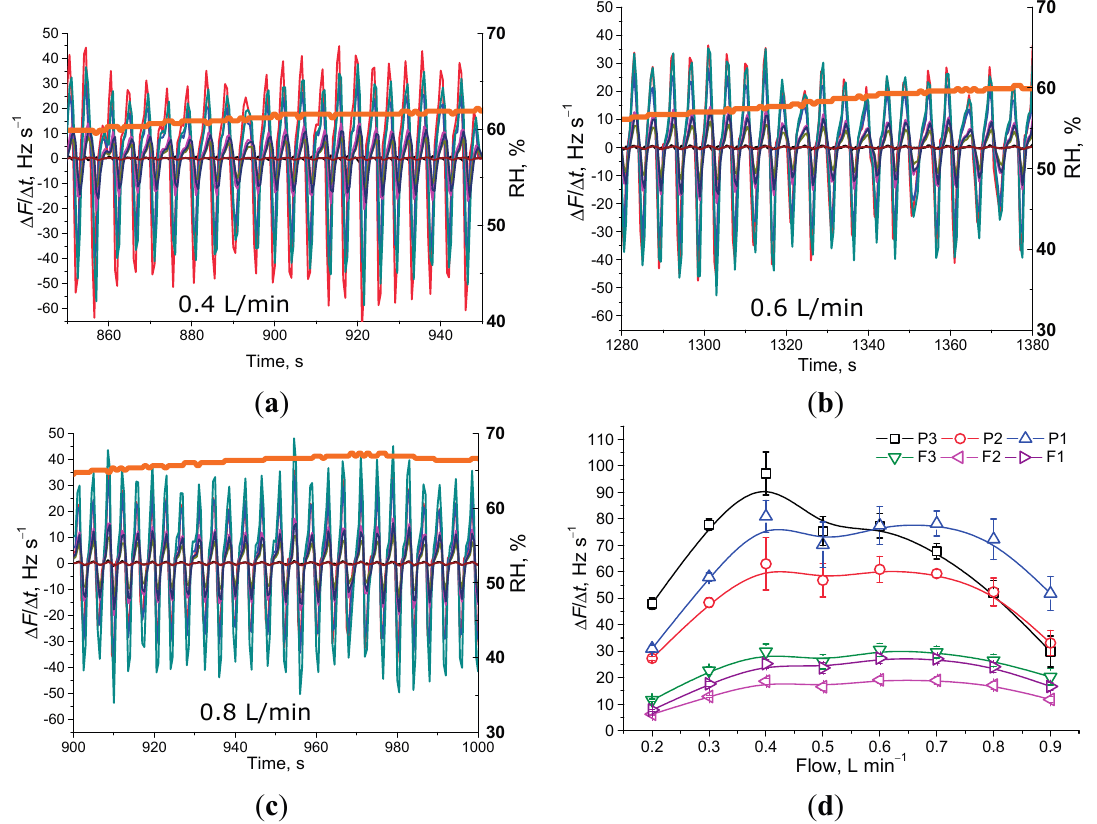
Figure 7. Response of the QCM sensor array to the respiration at different flows of the sample through the prototype system. ( a – c ) Speed of frequency change of all electrodes at three different flows (indicated in graph); ( d ) dependence of the amplitude of derivative change on the flow for all different